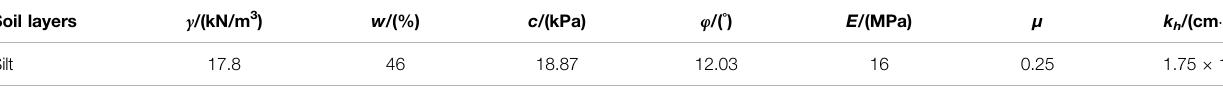
TABLE 8 | Geotechnical parameters of the silt subgrade slope. Soil layers